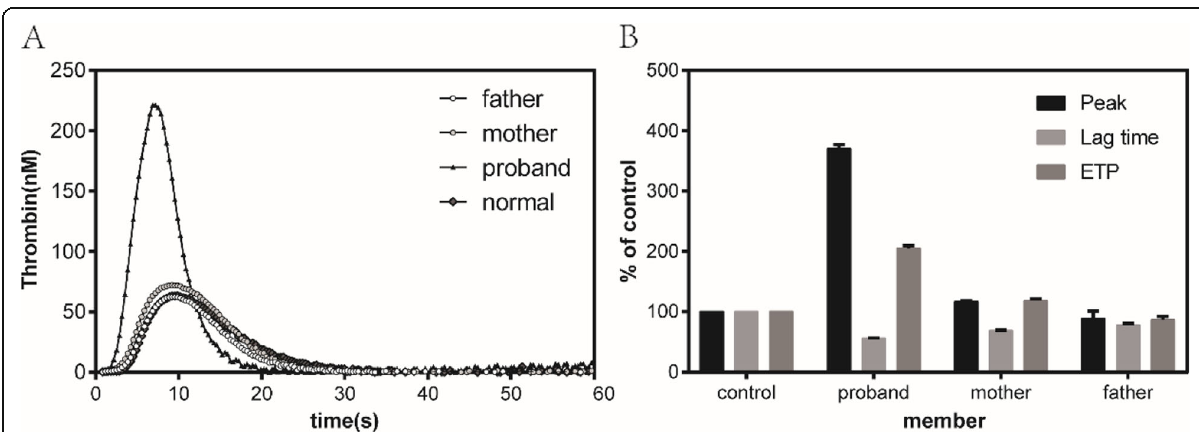
Fig. 2 High level of thrombin generation for the proband. A , representative thrombin generation curves for the proband and her parents in the plasma spiked with 1 pM tissue factor. B , ETP (black bars), peak thrombin generated (light bars), and LT (dark gray bars) of the plasma of the trio family were shown as a percentage of normal control